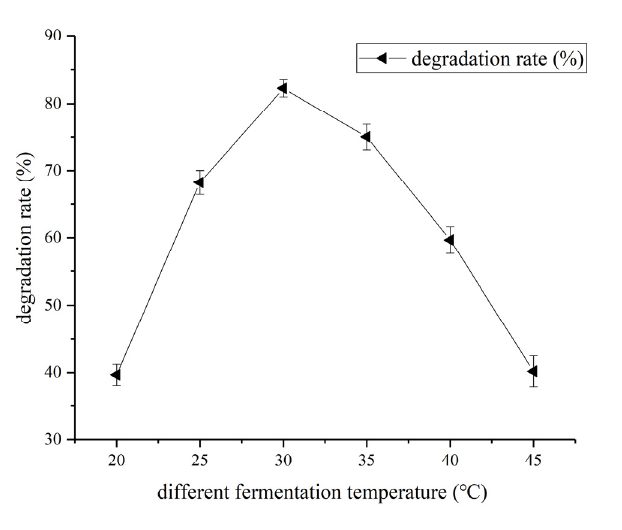
Figure 6. Effect of fermentation temperature on coumarin degradation rate. Data are expressed as mean ± SD of three independent experiments.